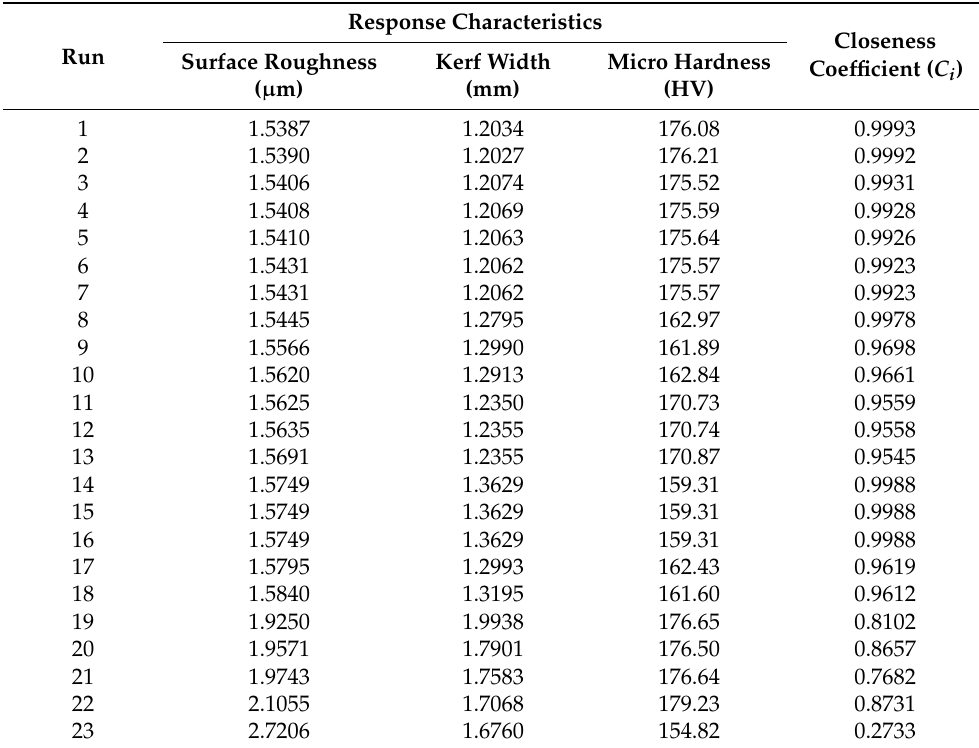
Table 8. Optimal values obtained through artificial bee colony algorithm.